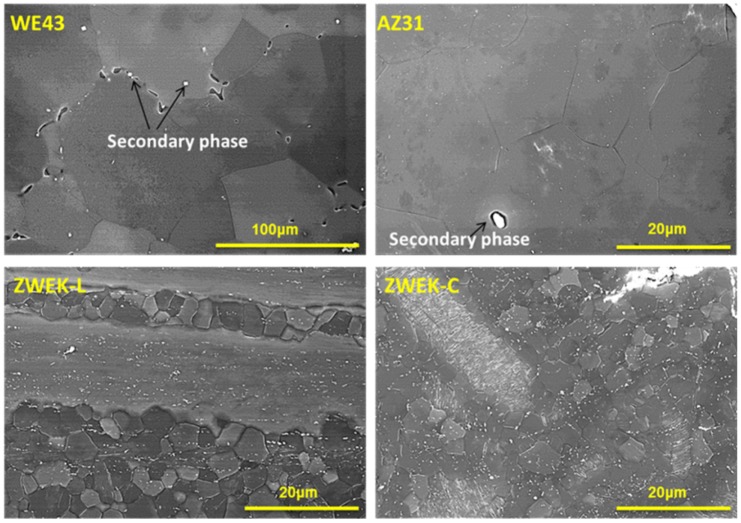
Grain structure of WE43, AZ31, ZWEK-L and ZWEK-C.Grain diameter (D) are: D(WE43) = 101±26μm, D(AZ31) = 15±7μm, D(ZWEK-L) = 5±1μm, D(ZWEK-C) = 5±2 μm.